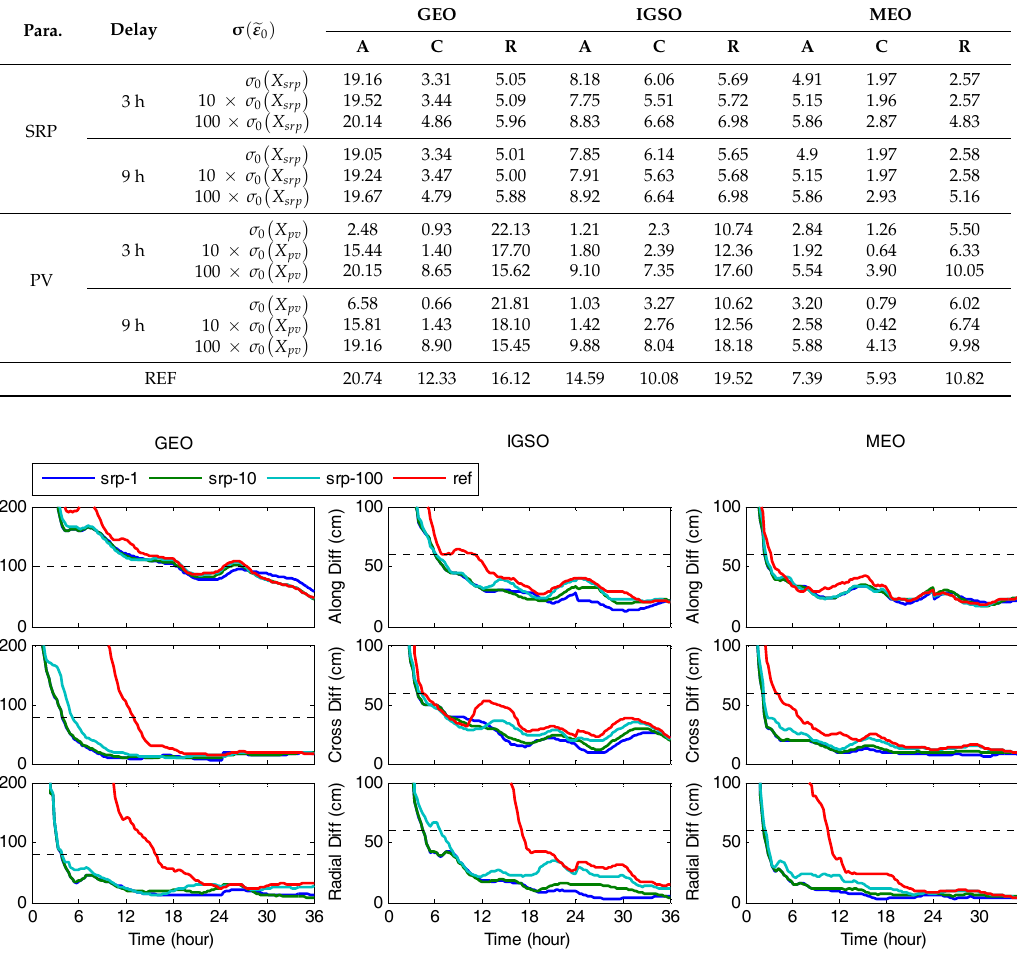
Figure 4. Time series of the average orbit accuracy using different a priori STD of SRP parameters. The UR product is used as the initial orbit and the latency time is 3 h. The horizontal black dotted line represents the convergence criteria for each direction.